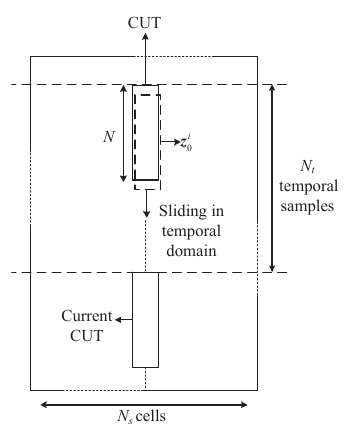
Figure 6. Procedure for estimating R A .